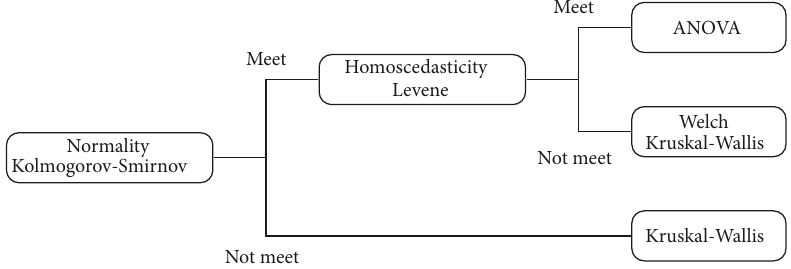
Figure 16: Methodology to determine the hypothesis test.